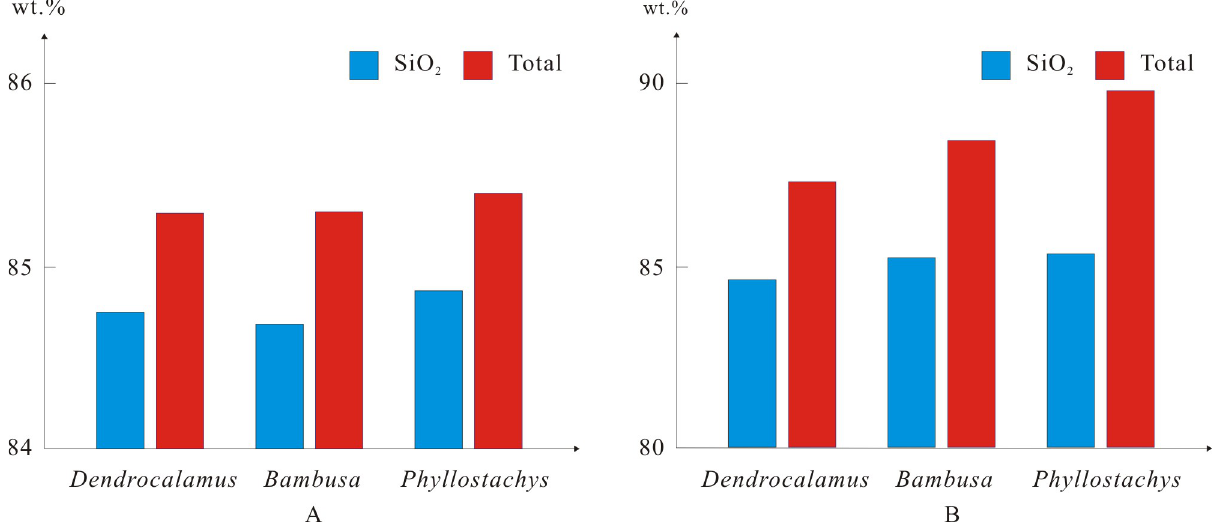
Fig 6. SiO 2 content and total values of phytolith EPMA varied between bamboo genera and ecotype. A, NCA (non-carbon analysis) method, B, Fix- C (Fixed C) method.